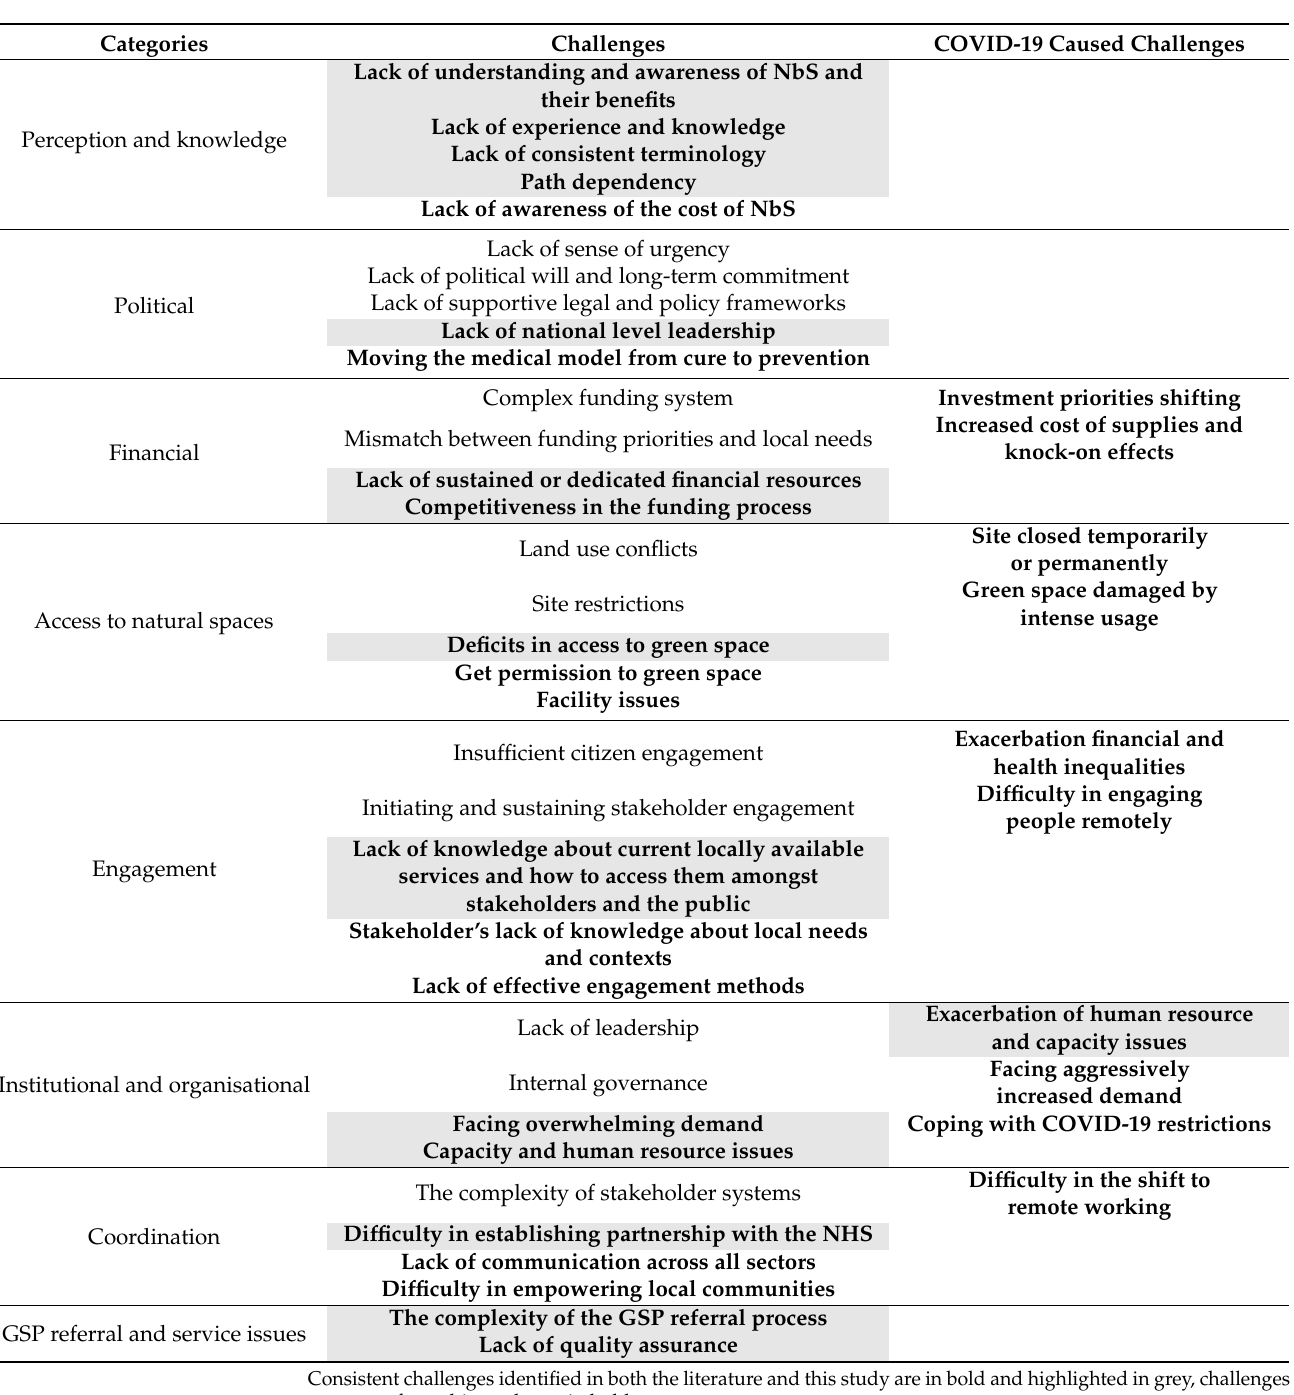
Table 2. Existing and emergent challenges to implementing